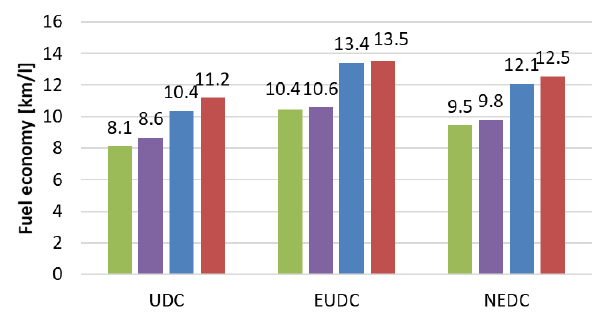
Fig. 17. Impact of resistance forces on fuel economy